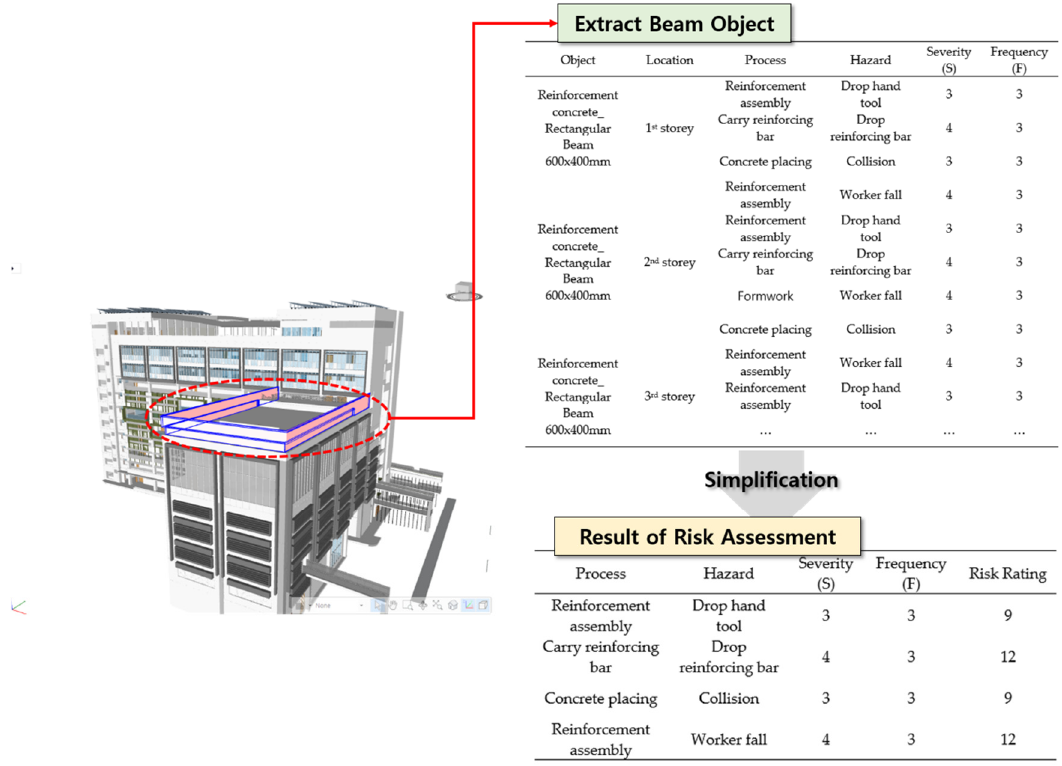
Figure 5. Simplification of hazard items for BIM-based risk assessment.